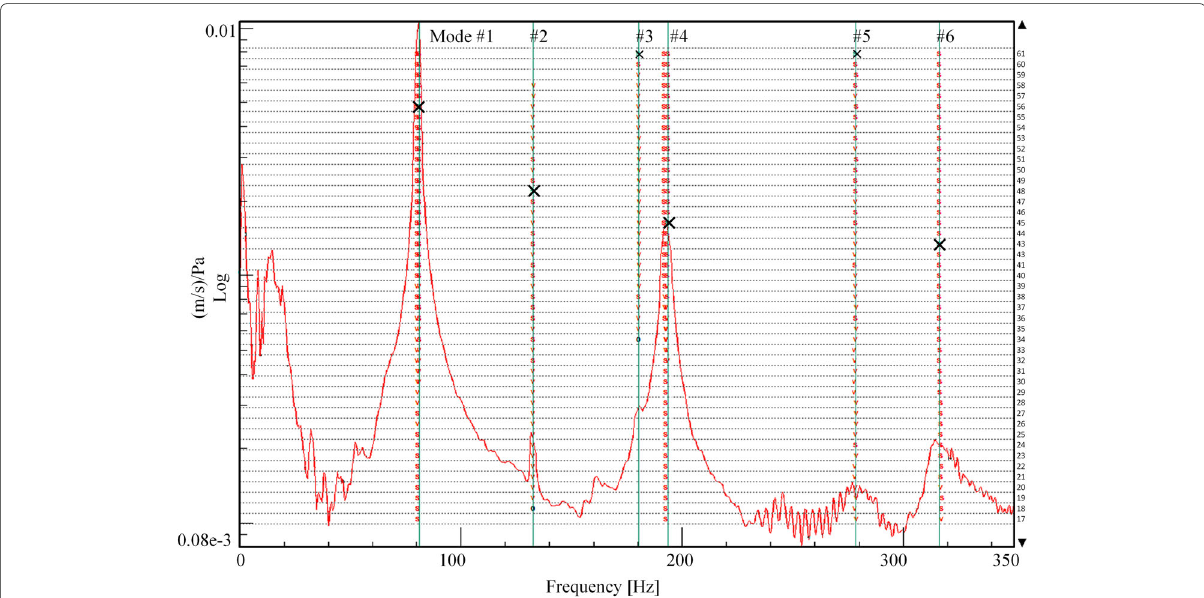
Fig. 16 EMA stabilisation diagram, showing the sum FRF with 2048 spectral lines, frequency resolution of 0.5 Hz and uniform windowing (the symbol “X” indicates selected